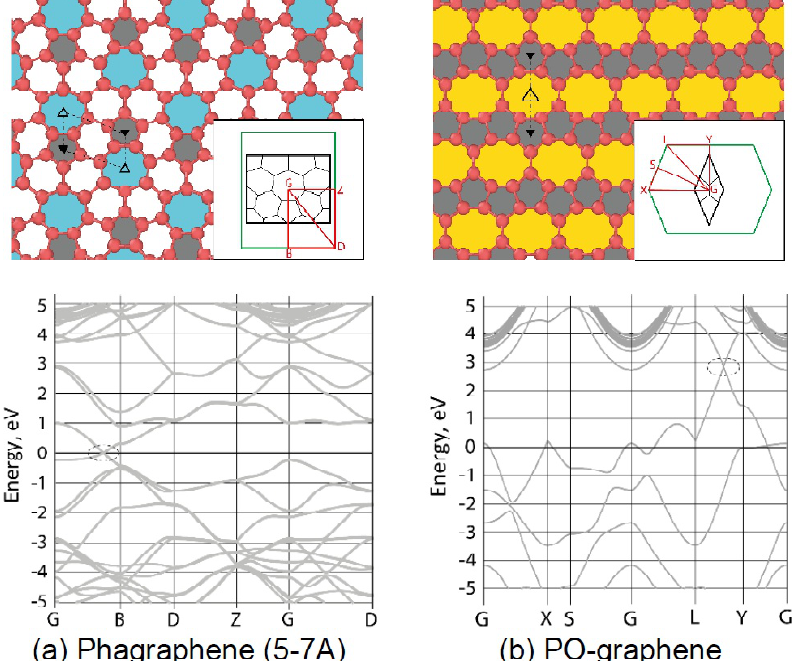
Fig. 3. Phagraphene (a) and PO-graphene (b) and their band structures (replotted using the data reported in [22,23]). In crystal structures, the disclination quadrupoles are depicted, and the insets show Brillouin zones. Dirac cones are outlined by dashed